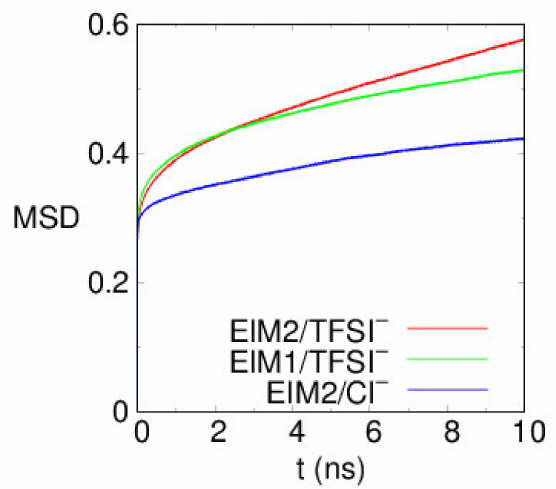
Figure 8. Mean square displacements (MSDs) of the center-of-mas of TFSI − and Cl − ions in the PILs, obtained at 300 K. The units of MSDs are Å 2